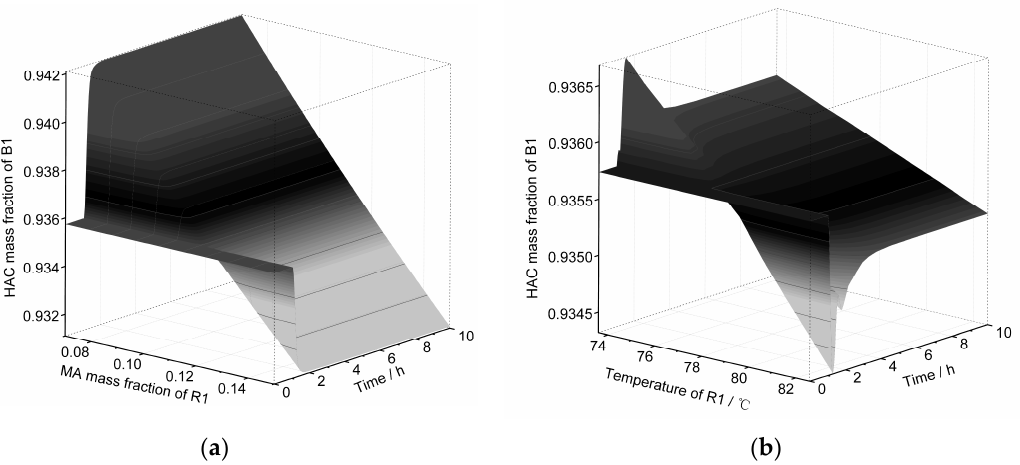
Figure 6. Sensitivity analysis of adding temperature controller. ( a ) Dynamic sensitivity analysis of the MA mass fraction in the R1 to the HAc mass fraction at the bottom of the column. ( b ) Dynamic sensitivity of temperature in the R1 to the HAc mass fraction at the bottom of the column.